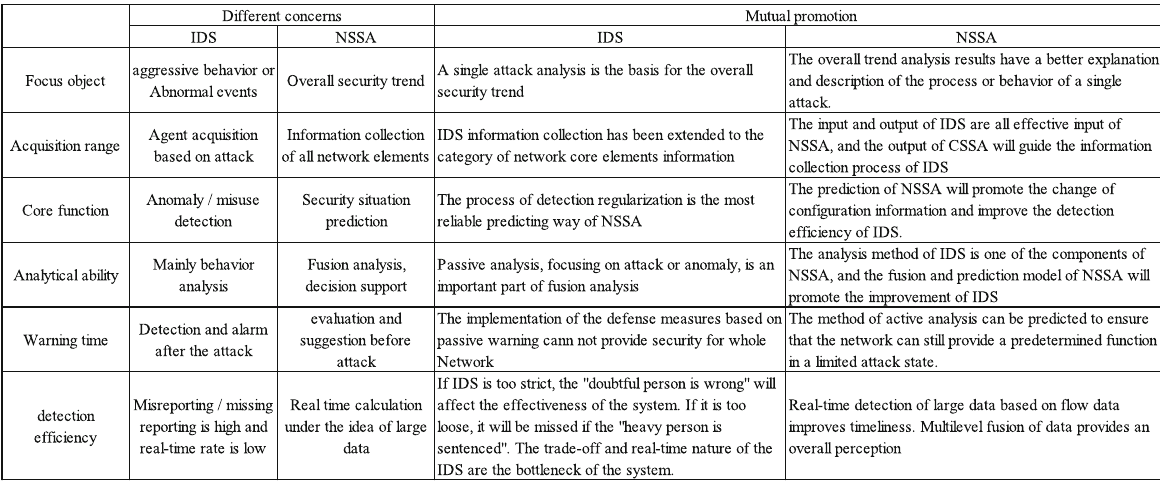
Table 2 The difference and connection between IDS and network security situational